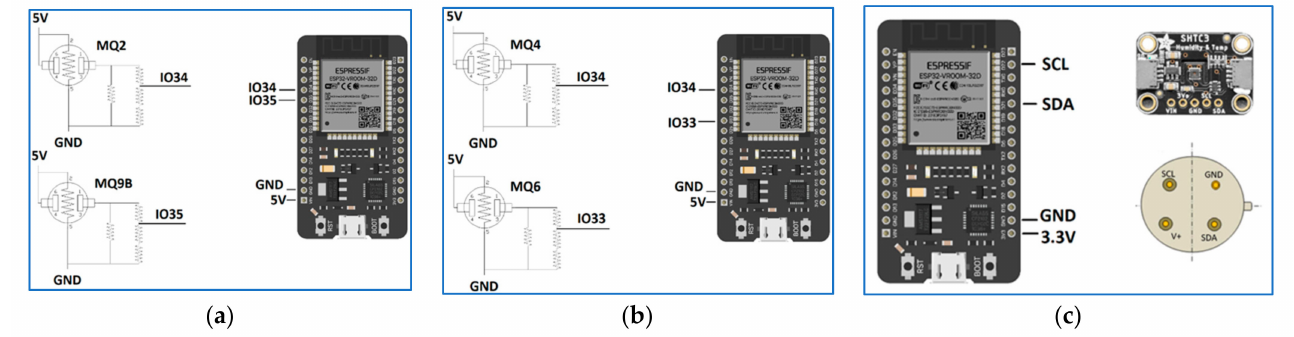
Figure 2. Physical outlook and pin configuration of the ESP32 microcontroller and its components for smoke/CO sensors ( a ), LPG /CNG sensors ( b ) and temperature/humidity/IR/flame sensors ( c ).